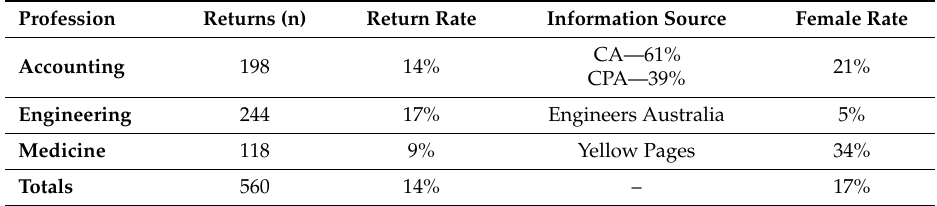
Table 2. Survey response overview.